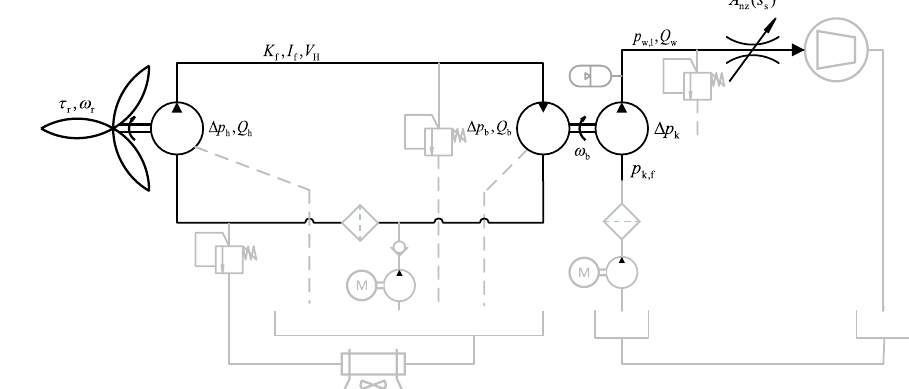
Figure 5. Schematic overview of the DOT500 hydraulic wind turbine drivetrain. All pumps and motors have a fixed volume displacement. Charge pressure pumps and filters are included on the low-pressure sides of both the oil and water circuits. Pressure relief valves are incorporated in both circuits. A parallel circuit around the oil reservoir is present for cooling